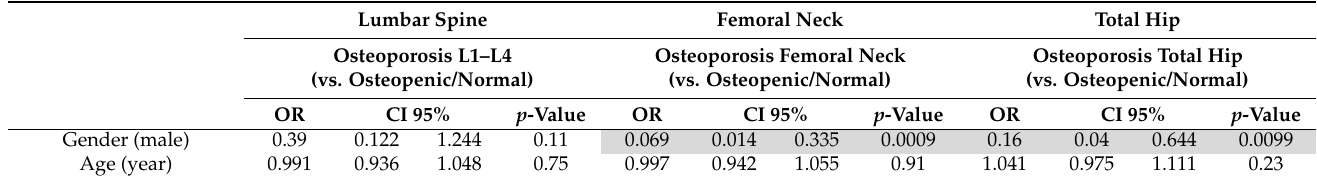
Table 3. Correlation between clinical/respiratory parameters and osteoporosis diagnosis (univariate